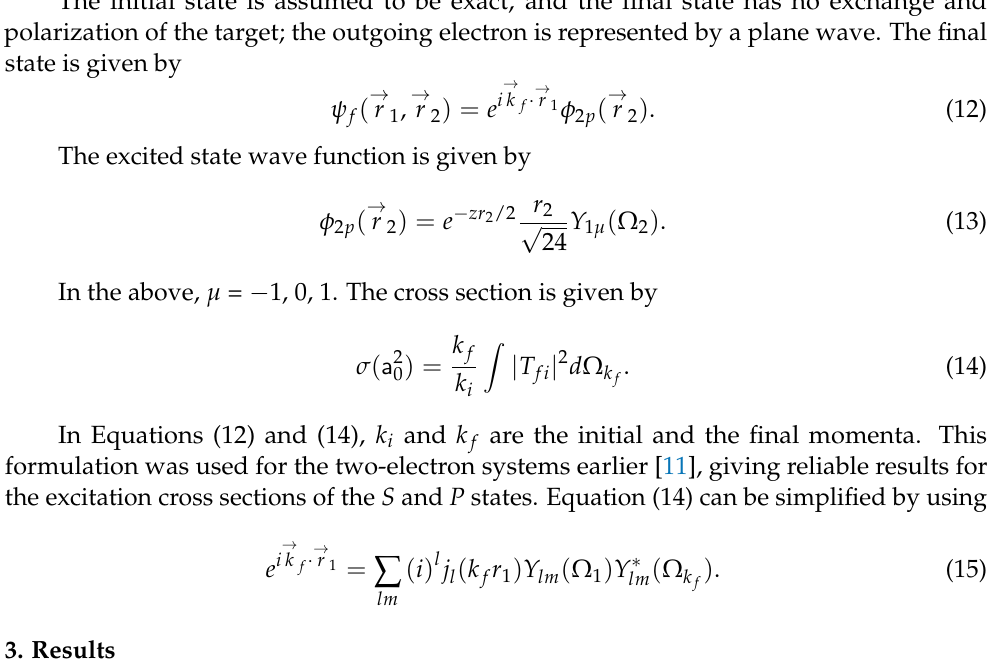
) for incident energies E 0